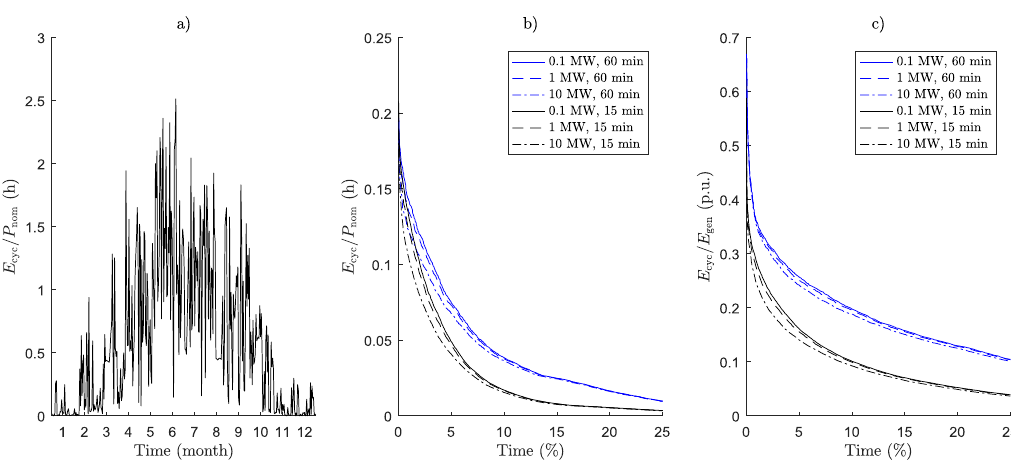
Figure 7. ( a ) Daily energy cycled through ESS in 2015 for the 0.1 MW PV power plant with 60 min ISP. Probability density distributions of the cycled energy; ( b ) with respect to the PV generator nominal power and ( c ) with respect to the PV generator electricity production for the studied generators and ISP times.